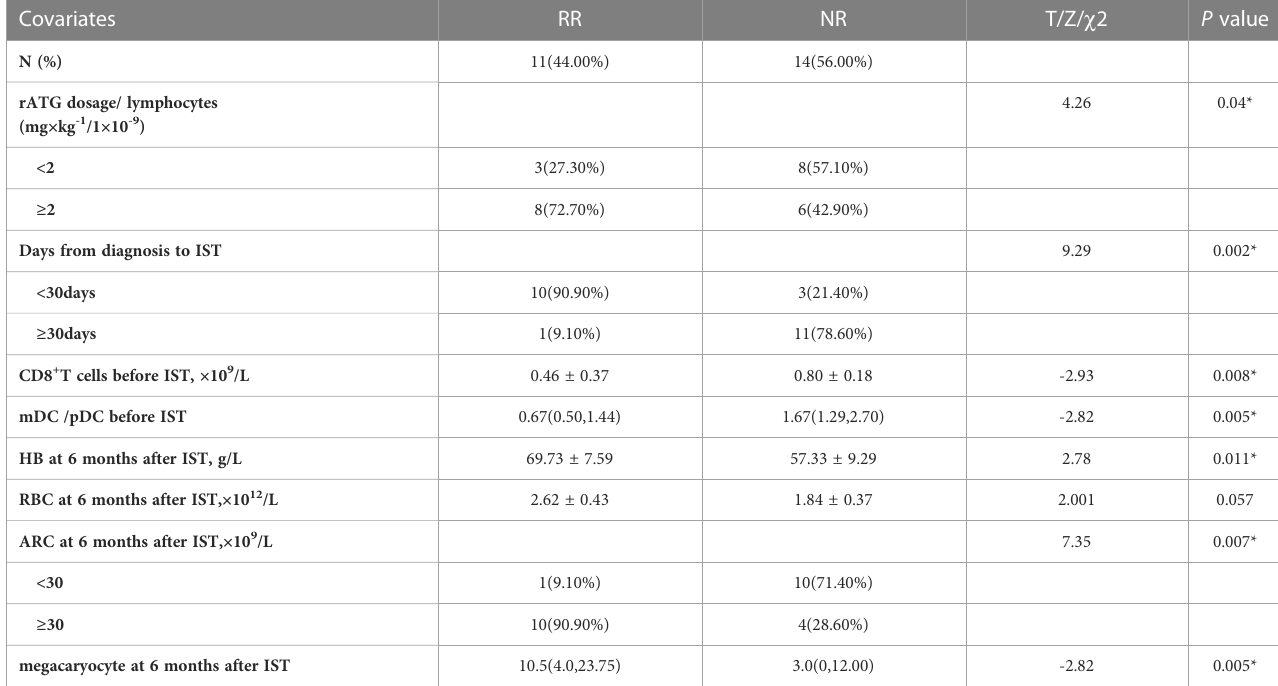
TABLE 2 Factors related to the ef fi cacy from 6 to 12 months after rATG with univariate analysis in CsA group. Covariates